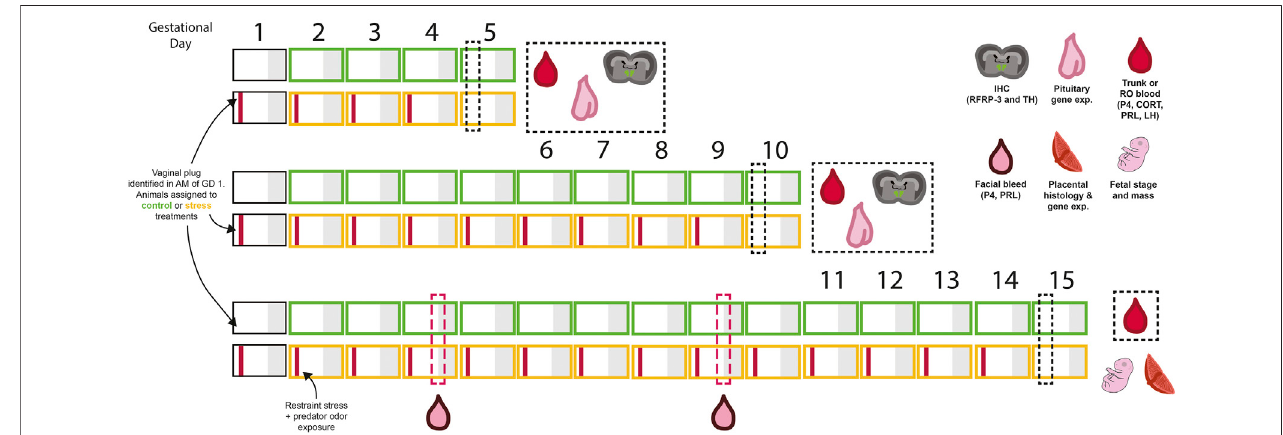
FIGURE 1 | A summary of the experimental design and sampling timeline used in this experiment. Each box represents 1 day, with grey shading representing the darkperiod.Animalswereassignedtoeithercontrol(green)orstress(yellow)treatmentgroupsonthedayvaginalplugswereidenti fi ed(gestationalday1).Acombination ofrestraintandpredatorodorwereusedasthepsychologicalstressor.Micewereexposedtothestressorinthemorningsoneachexperimentalday(indicatedbythered barwithineachbox).Tissueswerecollectedinthemorningondays5,10,or15ofpregnancyandtissuesforfurtheranalysis,asindicatedbycartoonsymbolsinthe fi gure.Foranimalssampledonday15ofgestation,eveningbloodsampleswerecollectedondays4and9toexaminetheeveningprolactinsurge.Refertomethodsand results text for further